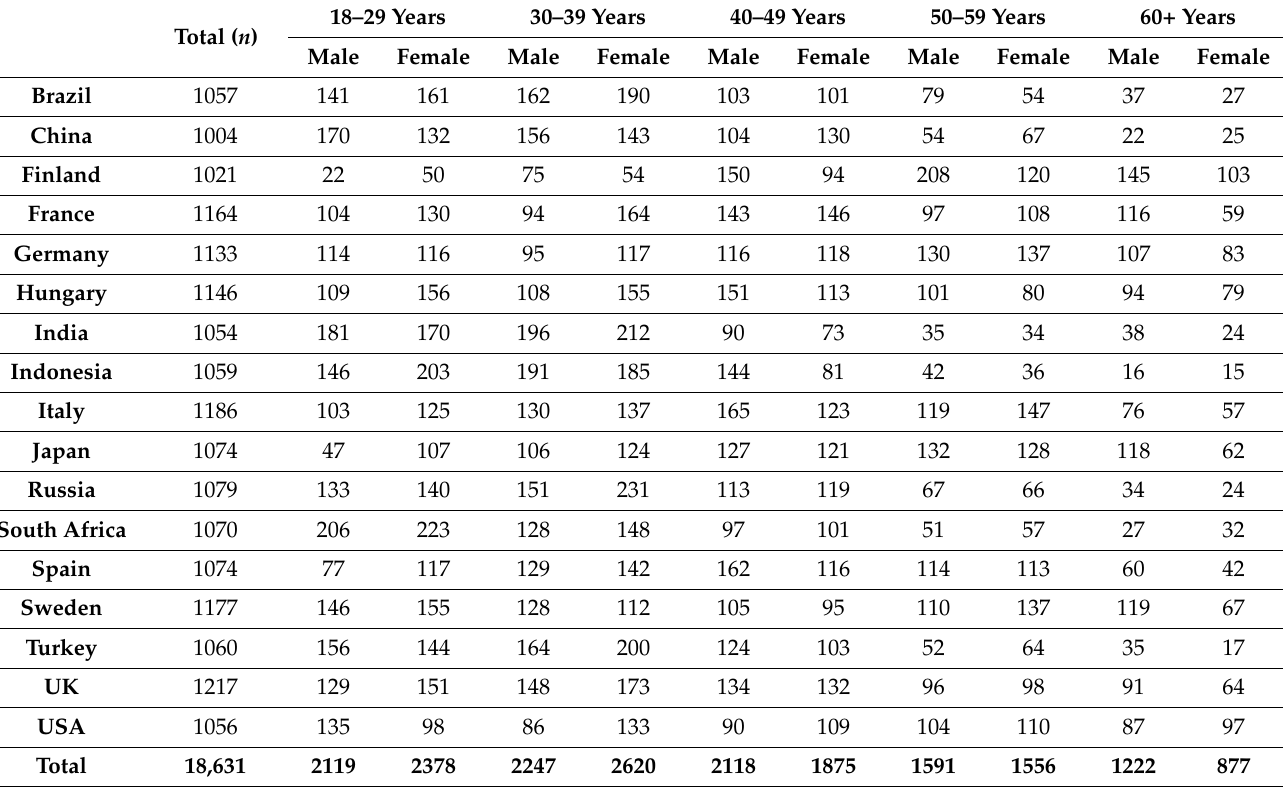
Table 4. Sample size for each country, segmented by age group and